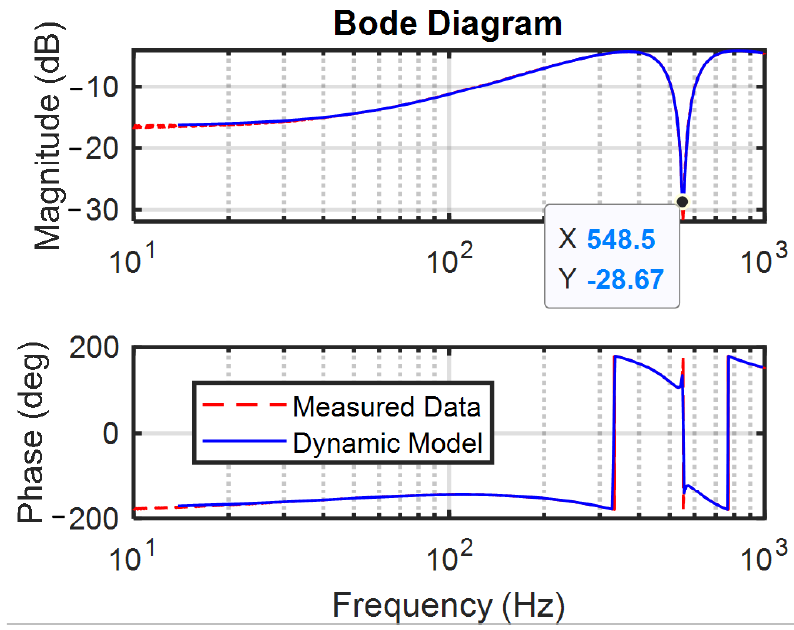
Figure 7. Bode plot of controller for URAMB along the X-axis.